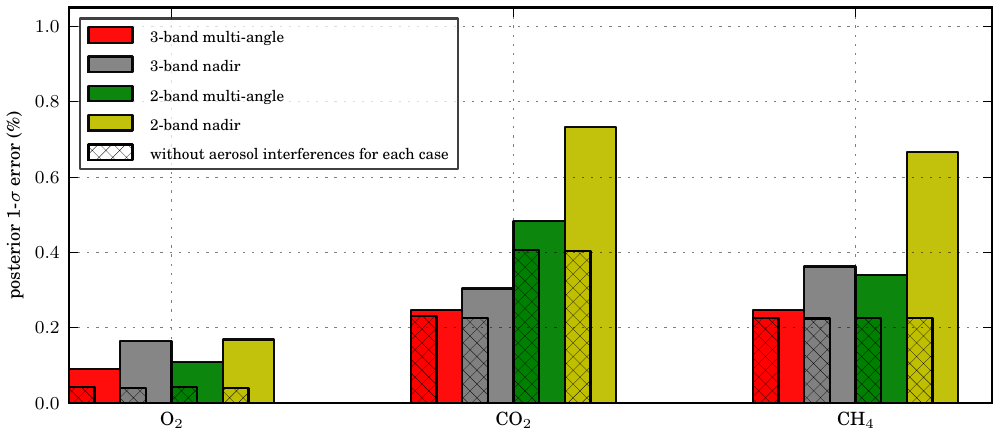
Fig. 9. Posterior error estimates (1 σ ) of trace gas total column amount in %. Summer case (see Table 2), OCO-2 spectral resolutions and SNR=200 for each spectrum was assumed.